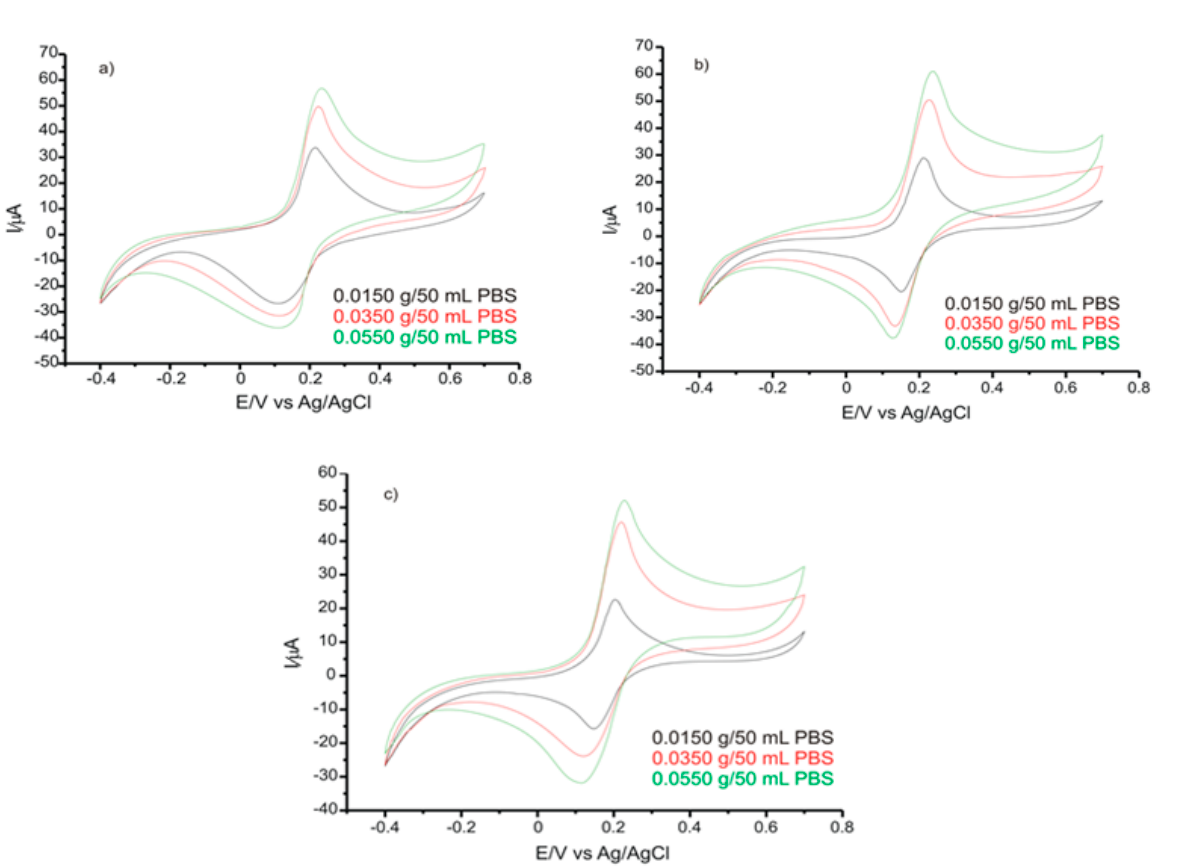
Figure 8. CVs of GPH-GNP-SPE immersed in solution with different concentrations prepared from ( a ) Green Coffee Extract (Rotta Natura); ( b ) Green Coffee (Pro Natura); ( c ) Green Coffee Fit (Pro Natura). Scan rate 0.1 V · s − 1 . Table 7. CGA content determined in three food supplements by using voltammetric and spectropho- tometric